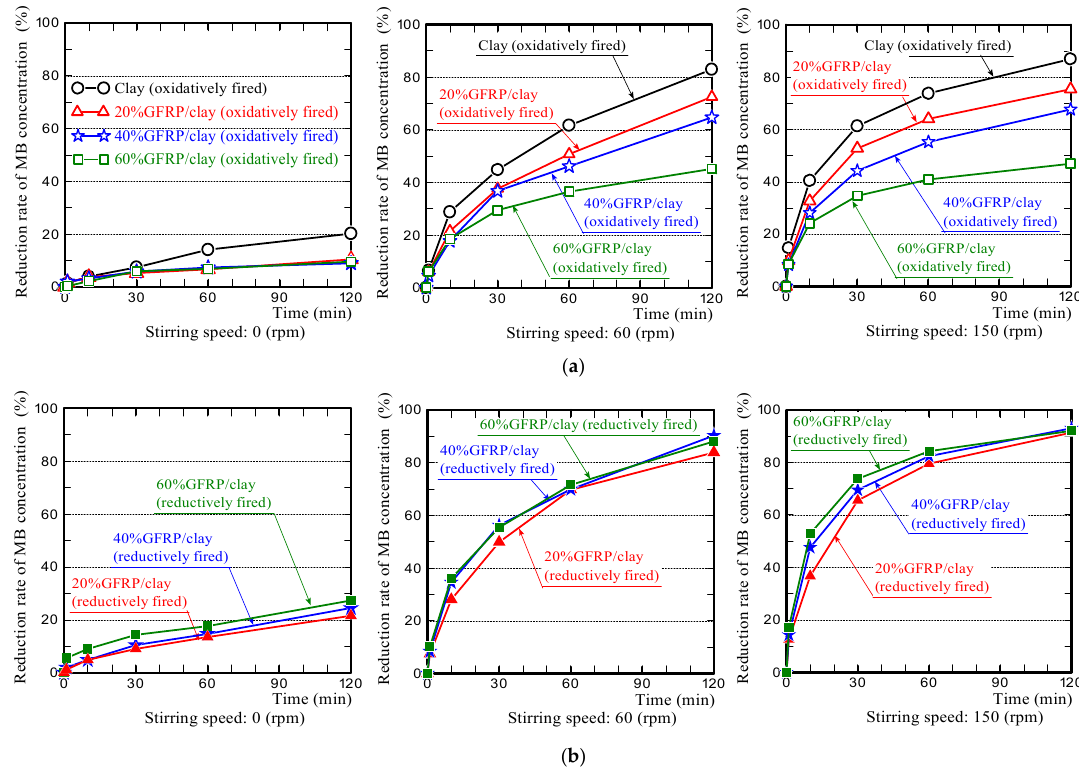
Figure 8. The reduction rate of the MB dye concentration for various GFRP / clay ceramics. ( a ) Oxidatively fired GFRP / clay ceramics. ( b ) Reductively fired GFRP / clay ceramics.